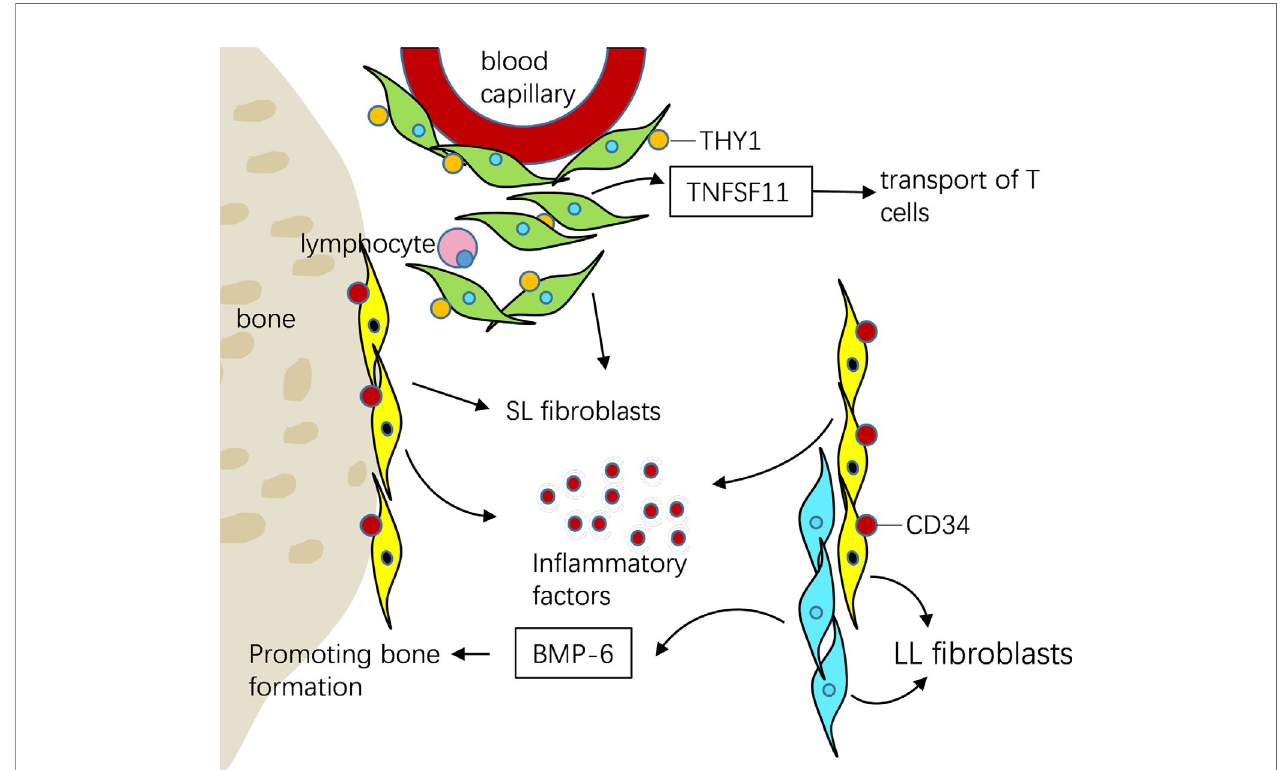
FIGURE 3 | ScRNA-seq showed that three different fi broblasts were distributed in different parts of synovial tissue and play different roles in RA. CD34+ fi broblasts were reported in super fi cial lining, as well as deeper sublining areas of the synovium. They promoted the progress of joint in fl ammation by secreting a large number of in fl ammatory factors. CD34 – THY1 – fi broblasts were remarkably reported in lining area and express BMP-6, recognized to enhance osteoblastic bone formation. CD34 – THY1+ fi broblasts in RA produce a discrete perivascular zone that surrounds capillary structures in the deep sublining layer of the synovium, it participate in the transport of T cells by overexpression of